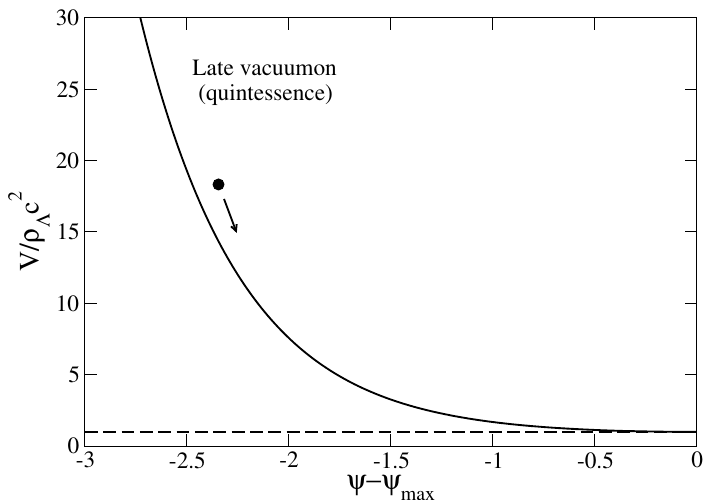
Figure 2. Potential of the scalar field in the late universe for α = 0. The late vacuumon plays the role of quintessence. The field tends to run down the